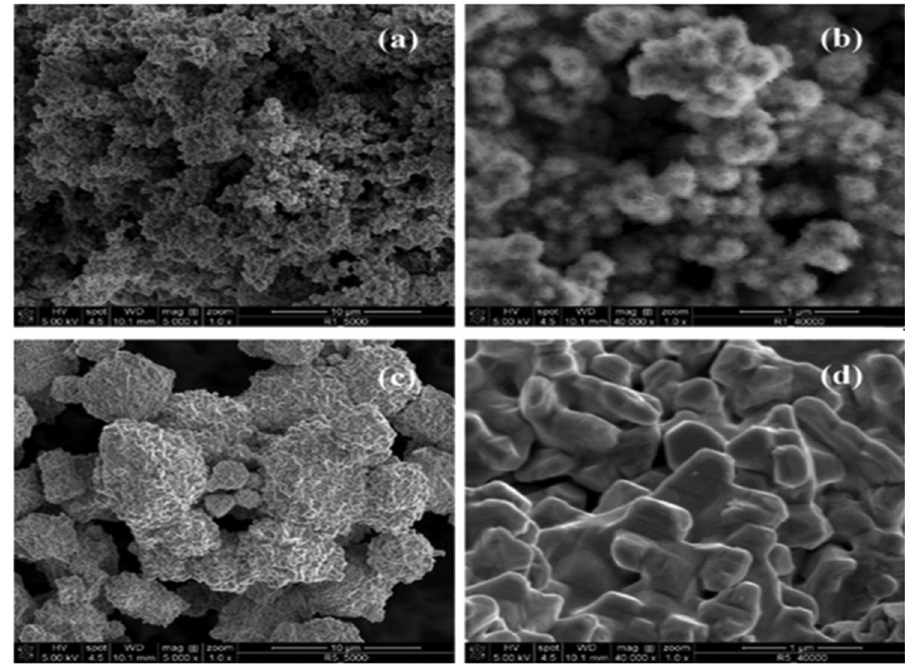
Figure 6: SEM characterization of nanosized nickel ( a and b ) and commercial nickel ( c and d ) , republished with permission [ 49 ]